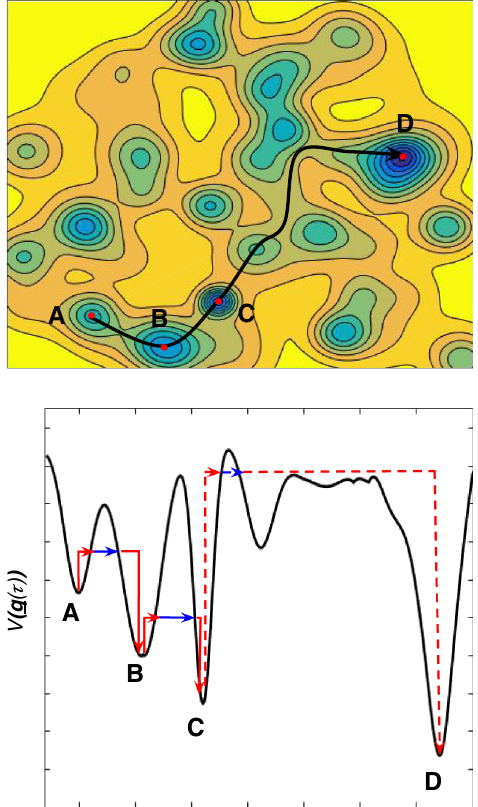
FIG. 1. Top: Quantum annealer dynamics are dominated by paths through the mean-field energy landscape that have the highest transition probabilities. Shown is a path that connects local minimum A to local minimum D. Bottom: Mean-field energy V ( q ð τ Þ ) along the path from A to D, as defined by Eqs. (12) and (16). Finite-range, thermally assisted tunneling can be thought of as a transition consisting of three steps: (i) the system picks up thermal energy from the bath (red arrow up), (ii) the system performs a tunneling transition between the entry and exit points (blue arrow), and (iii) the system relaxes to a local minimum by dissipating energy back into the thermal bath (red arrow down). In transitions A → B or B → C, finite-range tunneling considerably reduces the thermal activation energy needed to overcome the barrier. For long distance transitions in the lower part of the energy spectrum, such as C → D, the transition rate is still dominated by the thermal activation energy, and the increase in transition rate brought about by tunneling is